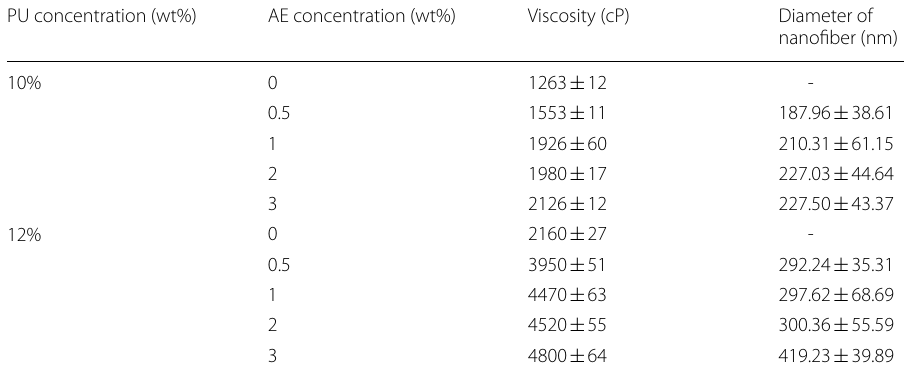
Table 2 Viscosity of the PU/AE spinning solution and diameter of PU/AE nanofibers according to the concentrations of PU and AE